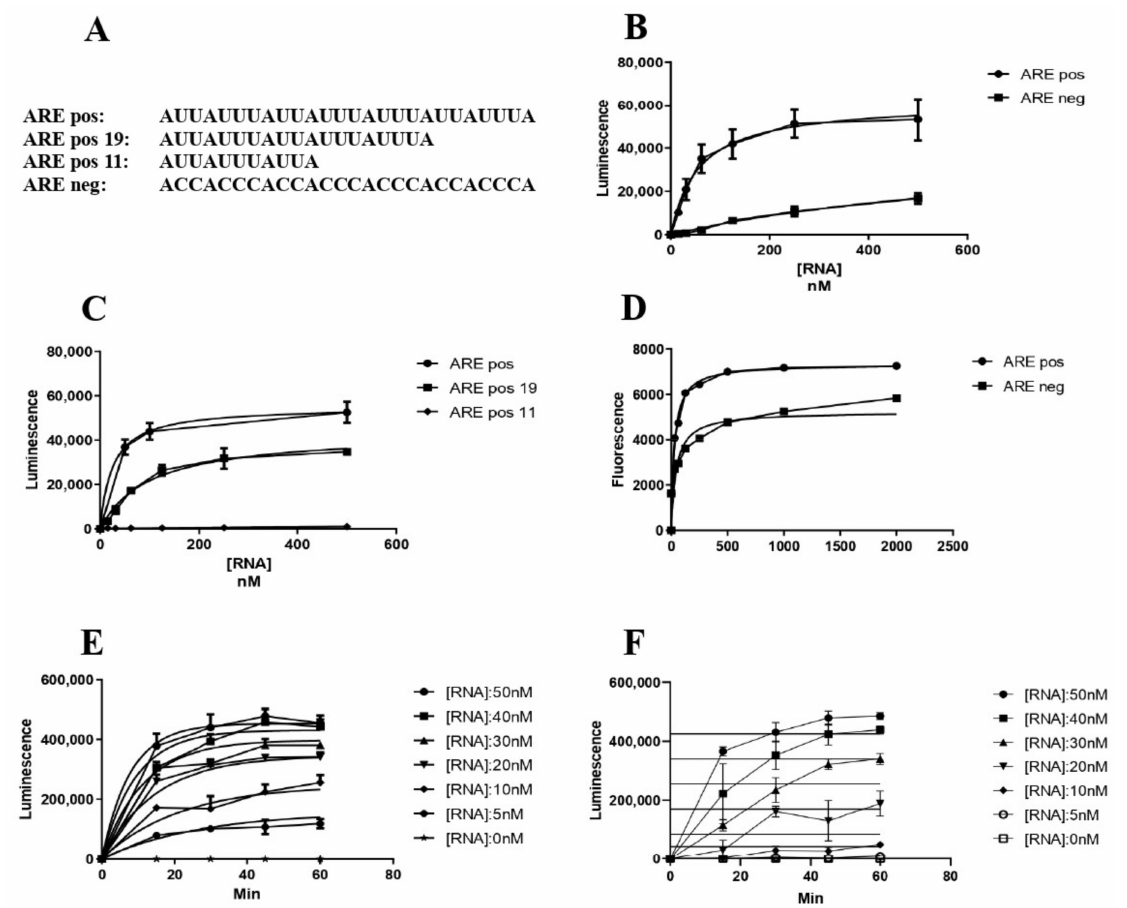
Figure 8. Biochemical characterization of the protein binding ability. ( A ) Sequences of the probes used in the different assays. ( B ) AlphaScreen saturation experiment between the recombinant protein and AREpos and AREneg. The EC 50 was determined from non-linear regression fits of the data according to the dose–response model in GraphPad Prism ® , version 6.1. ( C ) AlphaScreen saturation assay for detection of the minimal probe length for binding of the protein. The probe are AREpos with 3 (cid:48) deletions: ARE pos: ARE sequence full length, ARE pos 19: ARE sequence with 19 nucleotides, ARE pos 11: ARE sequence with 11 nucleotides. The minimal number of nucleotides in order to obtain the binding is 19, but longer sequences have a higher affinity. The EC 50 was determined from nonlinear regression fits of the data according to the dose–response model in GraphPad Prism ® , version 6.1. ( D ) EC 50 evaluation through saturation experiment by HTRF-FRET and AREpos and AREneg. AREpos is confirmed to have high affinity while AREneg is not well bound. The EC 50